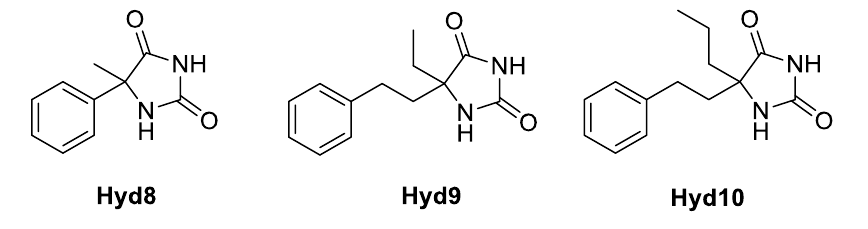
Figure 2. Phenyl hydantoin